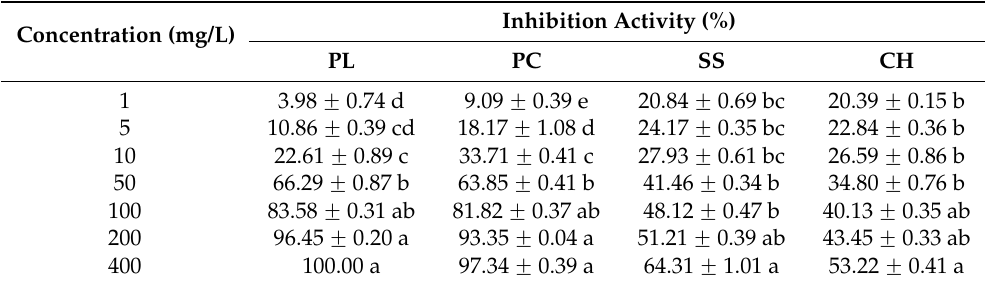
Table 1. Effect of isoliquiritin on four plant pathogenic fungi mycelial growth.